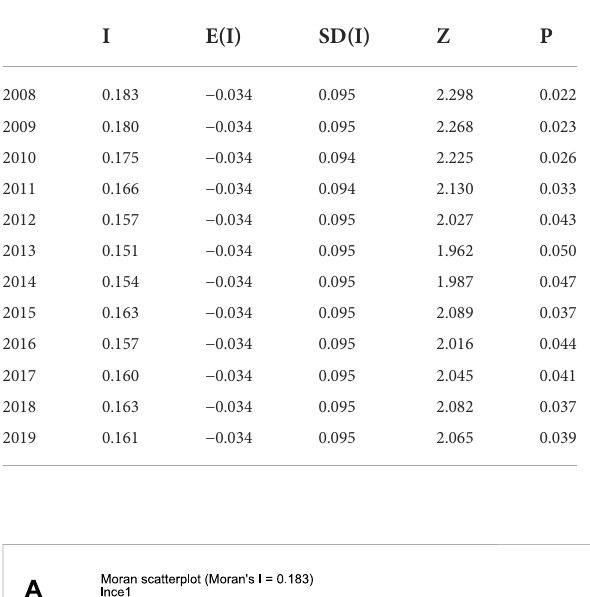
TABLE 4 Moran ’ I and its statistical test results.